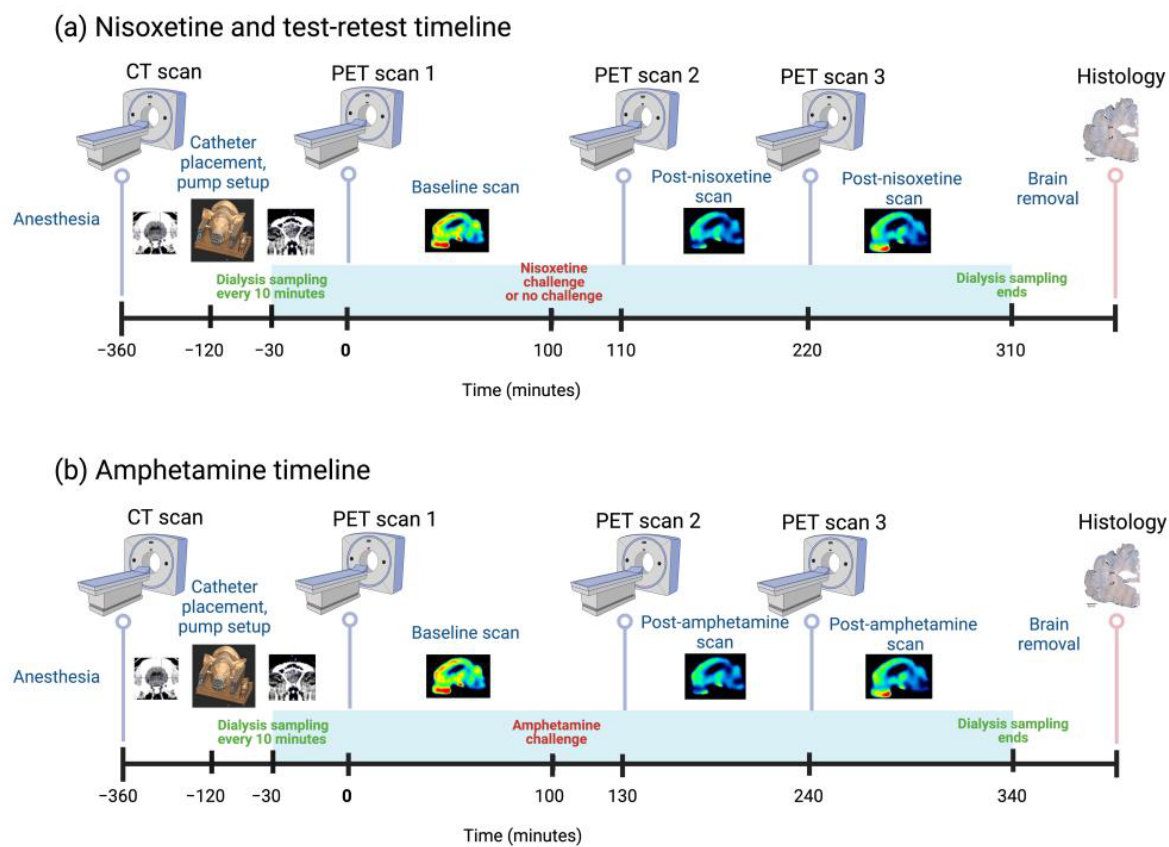
Figure 2. Timeline for experimental studies of drug challenges with either ( a ) 1 mg/kg nisoxetine or ( b ) 1, 2 or 10 mg/kg amphetamine. An overview of the general experimental setup in which minipigs were first deeply anesthetised and CT scanned. Minipigs then underwent surgical catheter place- ment in frontal cortex, striatum and thalamus, followed by a second CT scan to verify probe place- ment. We then sampled the dialysate every 10 min, alternated collection for NA and DA analysis and continued until the end of the PET scans. [ 11 C]yohimbine PET was performed at baseline (set as time 0) and at two temporal points after each challenge. Please note that the test–retest experiments followed the same timeline as nisoxetine and that the times indicated in each panel are a best ap- proximation of the actual times in each animal. Created with BioRender.com (accessed on 11 April 2023).